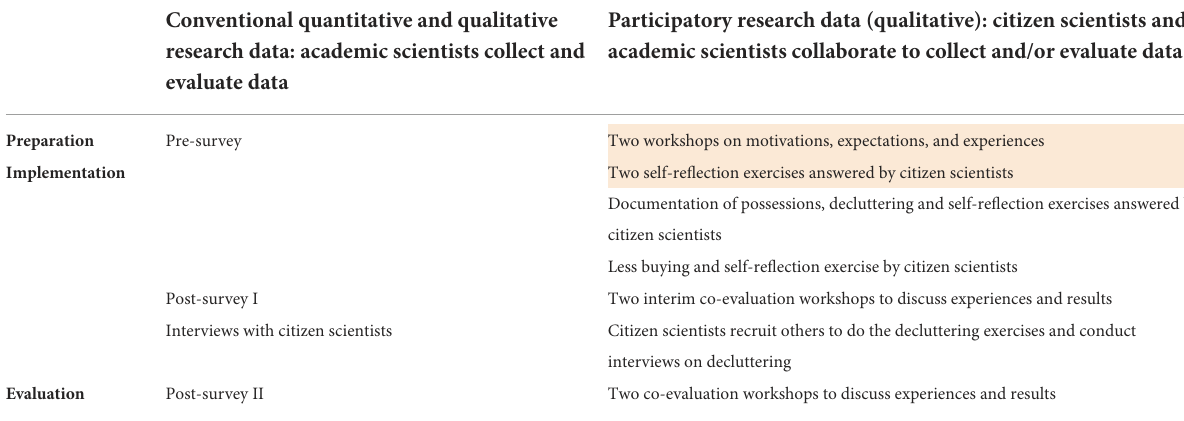
TABLE 1 Course of the research process and type of data collection (The highlighted data are presented in this article). Research